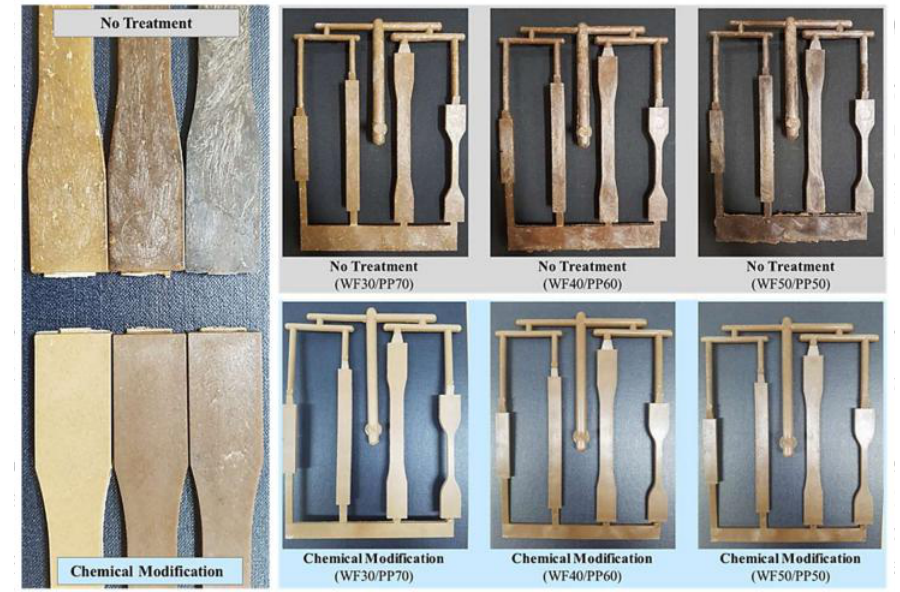
Figure 6. Chemically modified and untreated wood-plastic composite injection-molded ASTM